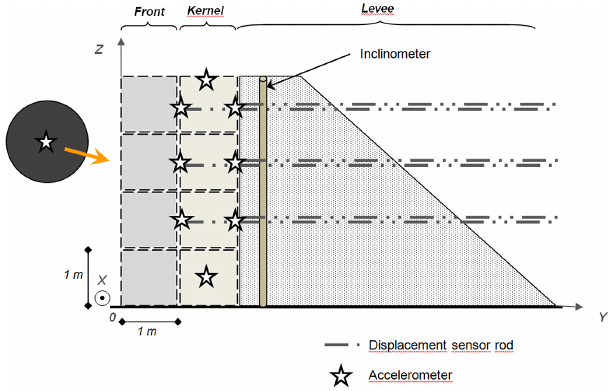
Figure 3. Cross section of the tested structure in the impact plane and measuring